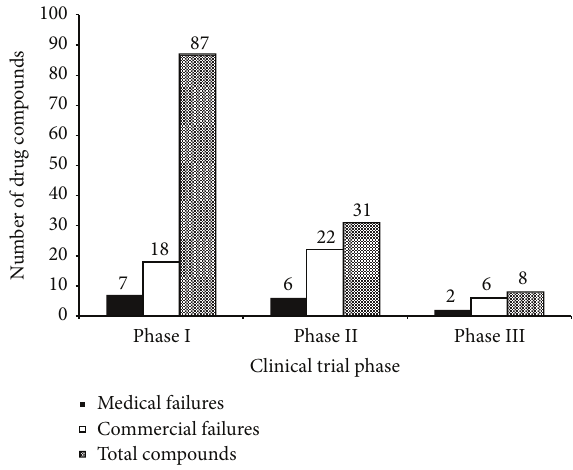
Figure 1: Clinical trial success rates. Clinical trial success rates in hepatitis C are compared against the industry expectations for each phase of clinical trial testing. The transition probability indicates the likelihood that a drug will successfully complete the phase of testing and will transition to the next phase or FDA approval for those in phase III. Cumulative pass rates represent the product of the probabilities of all three clinical trial phases. The sample size, 𝑛 , indicates the number of drug compounds that have successfully completed that phase.